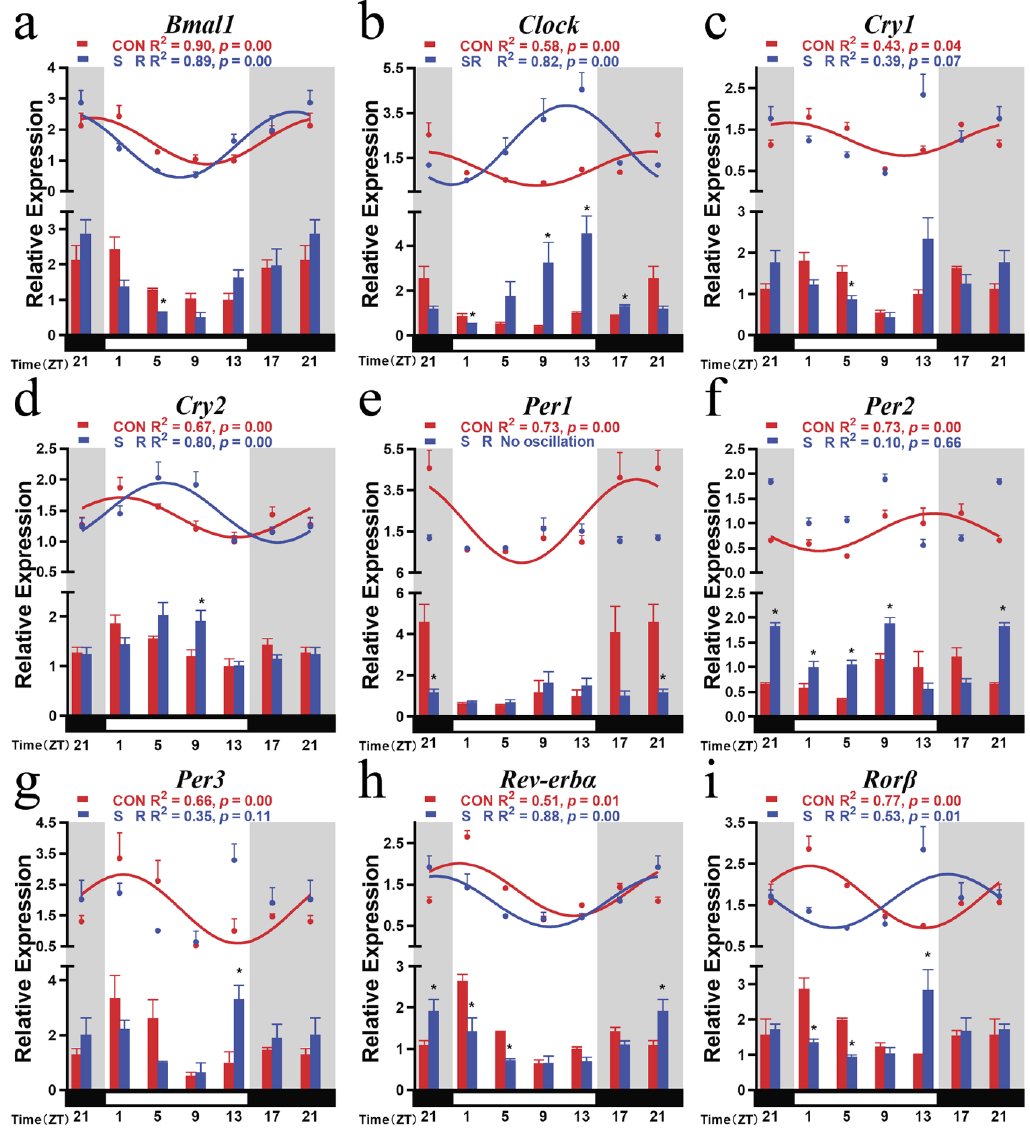
Figure 2. Temporal changes in the mRNA levels of nine clock genes in the hypothalamus of mice in SR group. ( a ) Bmal1 , ( b ) Clock , ( c ) Cry1 , ( d ) Cry2 , ( e ) Per1 , ( f ) Per2 , ( g ) Per3 , ( h ) Rev-erbα , ( i ) Rorβ . The horizontal white bar on each figure represents the subjective daytime, and the black bar represents the subjective night. The relative mRNA levels were normalized to Gapdh and presented as the fold of ZT13; n = 3 mice per time point. Quantitative analysis of the PCR data is shown as the mean ± SEM. The curve indicates the best fit to the points by cosinor analysis. R 2 values represent the degree of fitting. *: p -values indicate the significance of regression analysis, with significance defined as p < 0.05. The comparison at each time point uses t -tests.